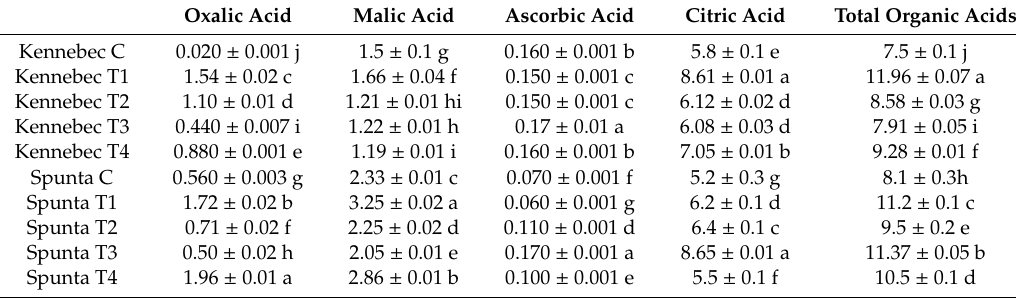
Table 5. Composition in organic acids (g / kg fw) of the studied potato varieties in relation to the fertilization regime (mean ±